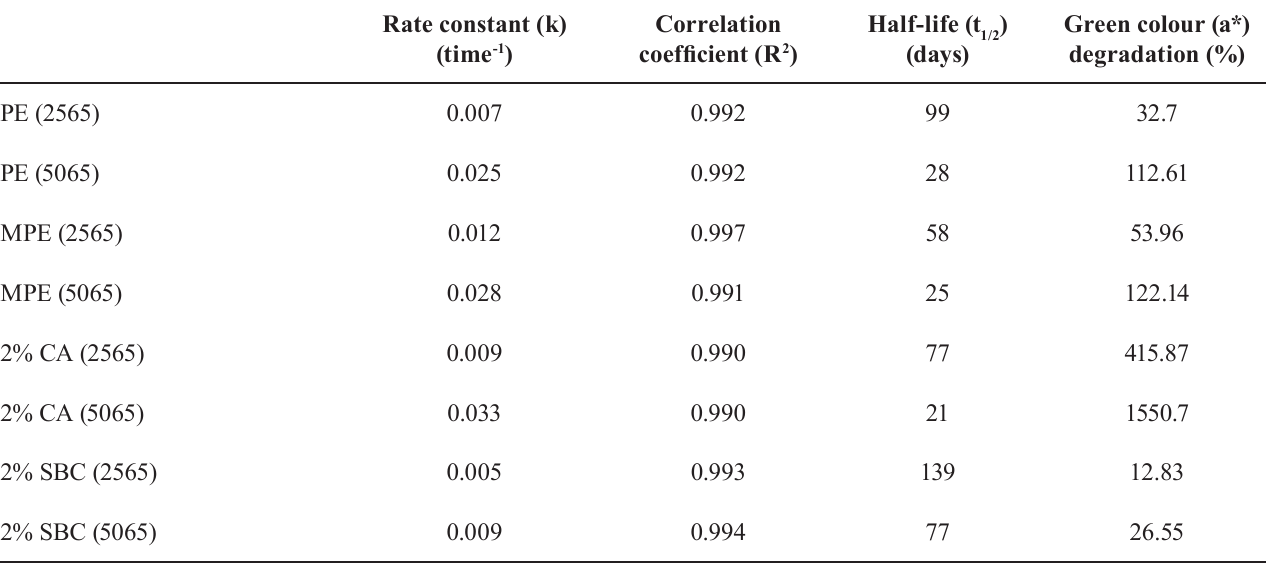
TABLE VI - Rate constant (k), correlation coefficient (R2) and half-life (t1/2) for green colour (a*) degradation of rice:spirulina blend (97:03) extrudates prepared with/without addition of additives (packed and stored in different